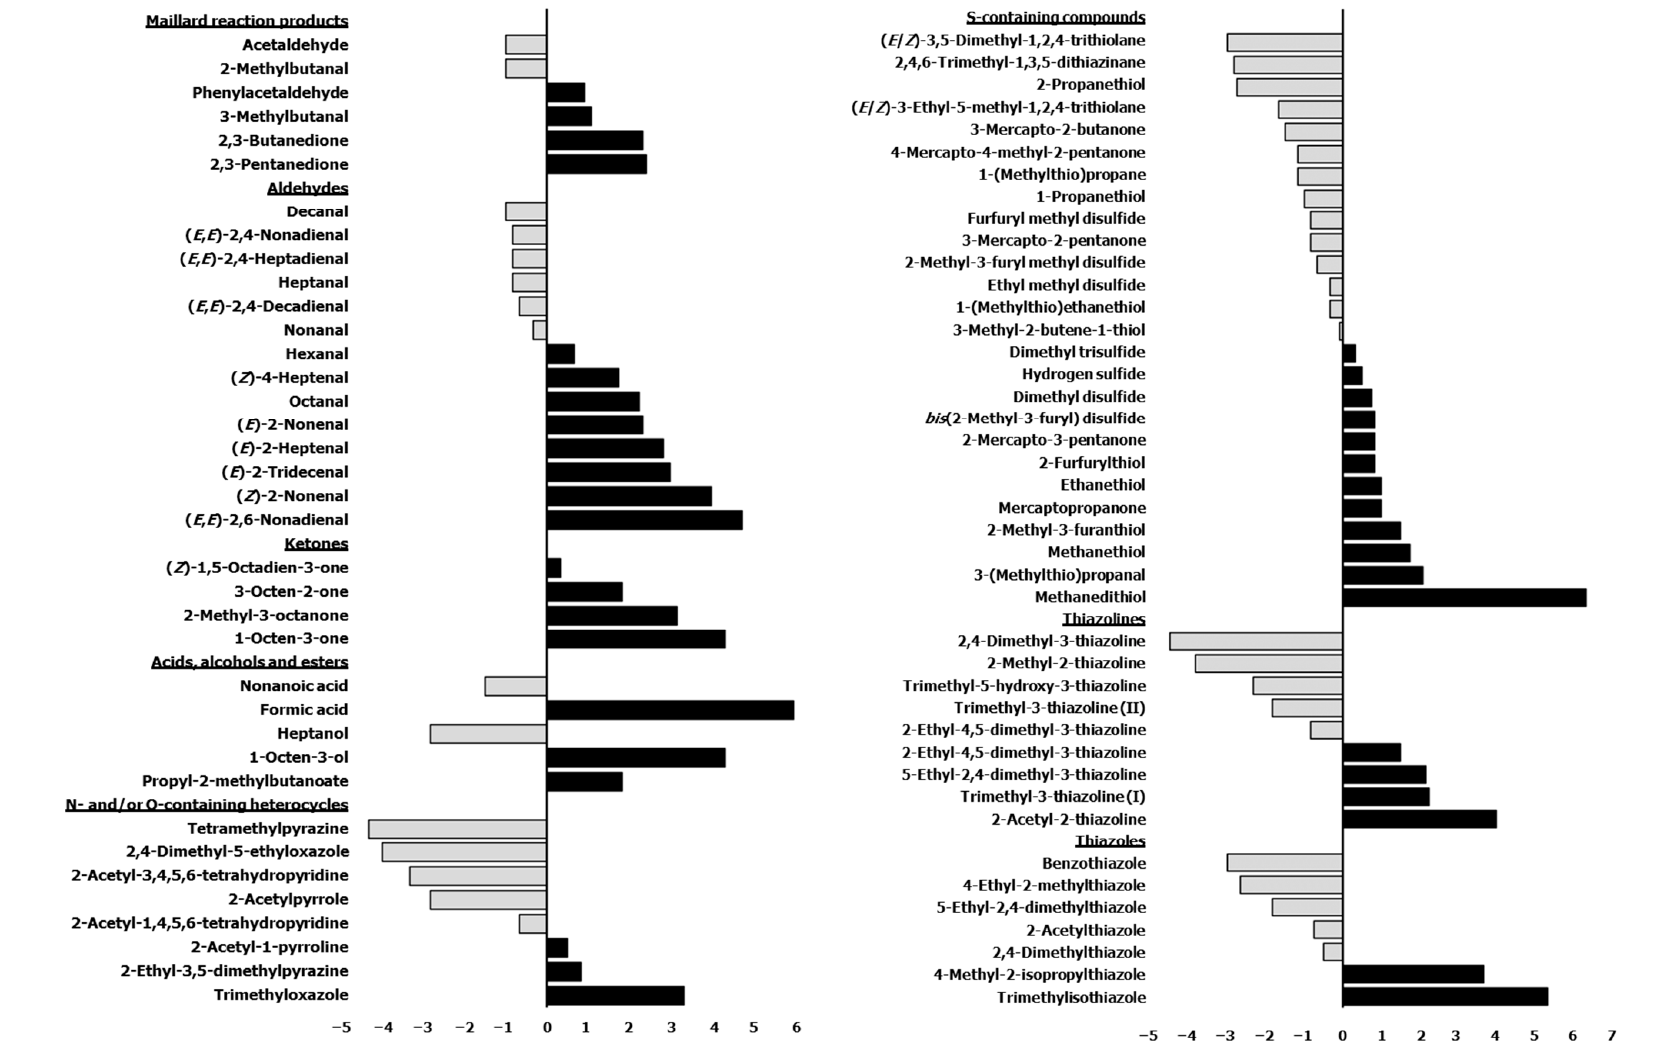
Figure 1. Difference in mean odour intensities of duplicate samples recorded by three panellists on DB-5 column between BB and BC extracts (positive values indicate that the compound was present at a stronger intensity in BB than BC and vice versa for the negative values).